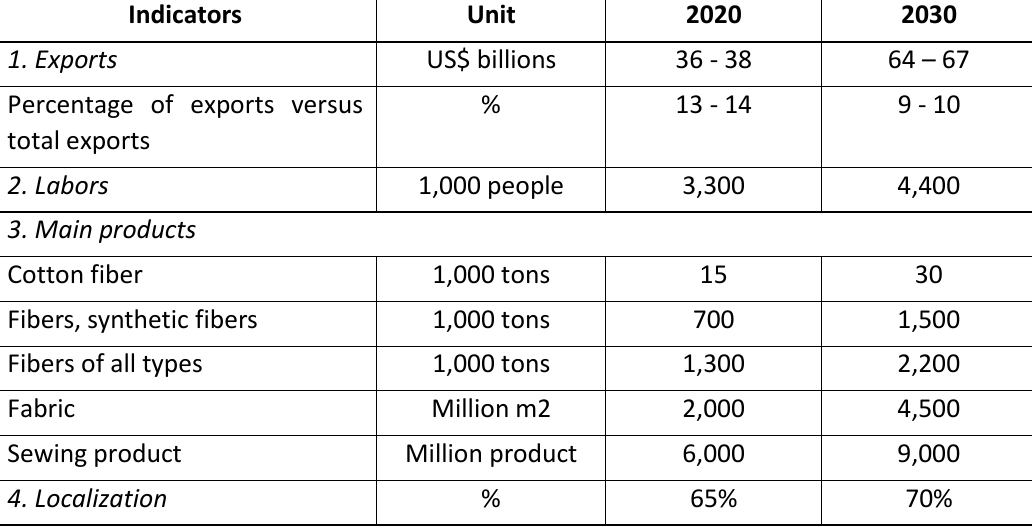
Table 3. Some development goals of the textile and garment industry to 2020 and